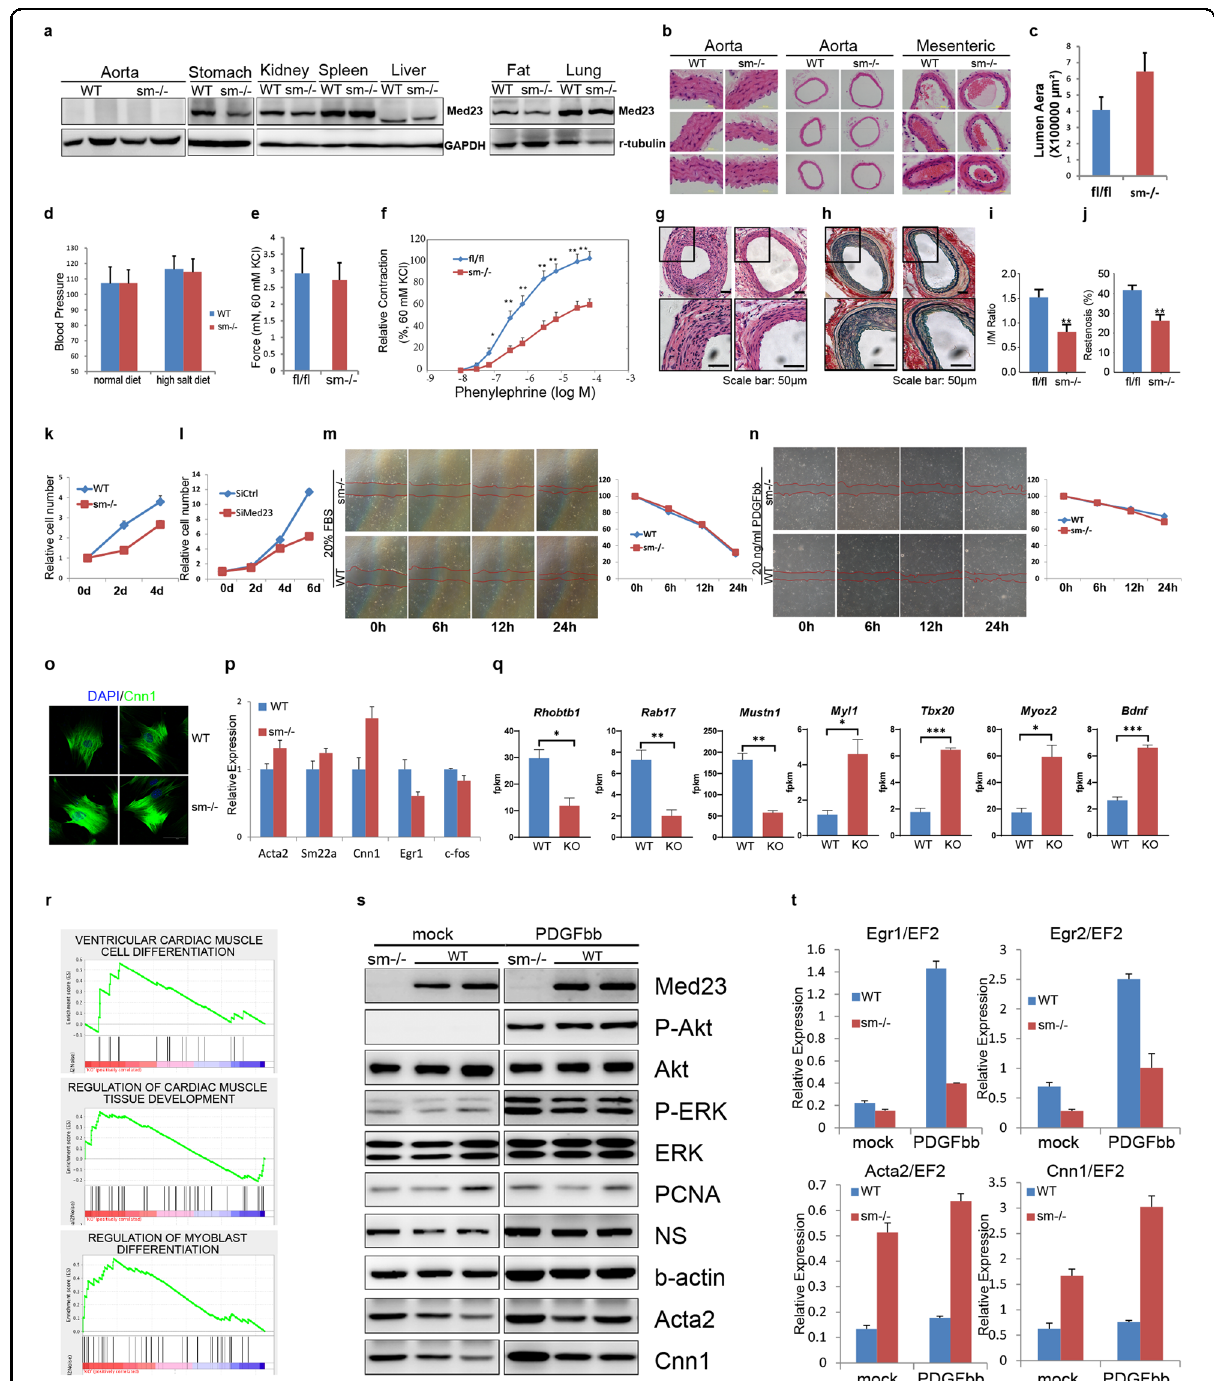
Fig. 1 Med23 de fi ciency in smooth muscle cells prevents neointima formation after arterial injury. a Immunoblot of Med23 in various tissues isolated from Med23 sm − / − and control mice. b , c Aorta, mesenteric arteries ( b ) and aortic lumen area ( c ) in Med23 sm − / − and control mice. d Blood pressure of Med23 sm − / − and control mice on normal or high salt diets. e Isometric contraction of aorta rings prepared from Med23 sm − / − and control mice (60 mM KCl). f Dose-response curves for PE-induced contraction in Med23 sm − / − and control aortas (60 mM KCl). g Representative H/E staining of femoral arteries from Med23 sm − / − and control mice. h Representative elastin staining of femoral arteries from Med23 sm − / − and control mice. i , j Intima-to-media ratio ( i ) and restenosis index ( j ) of femoral arteries harvested from Med23 sm − / − and control mice. k Cell proliferation of VSMCs isolated from the aorta. l Cell proliferation of A7R5 cells after viral-mediated siRNA knockdown of Med23 . m , n Wound healing assay in the presence of either 20% FBS ( m ) or 20 ng/ml PDGFbb ( n ). o Immunostaining of Med23 sm − / − VSMCs. p Expression levels of SMC genes and growth-related genes in the isolated VSMCs. q , r RNA-seq analysis of the aorta samples from Med23 sm − / − mice. s , t Western blot ( s ) and real-time PCR ( t ) of isolated VSMCs from control and Med23 sm − / − mice. NS, nucleostemin. Data are presented as means ± SEM. * P < 0.05, ** P < 0.01, *** P < 0.001, vs